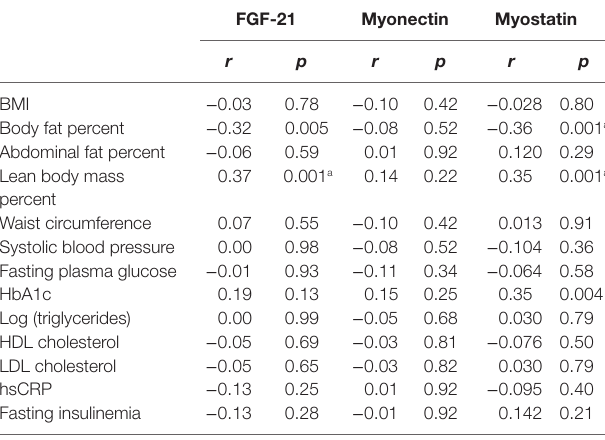
TaBle 2 | Spearman’s correlation coefficients between plasma myokines and clinical surrogates of insulin resistance.